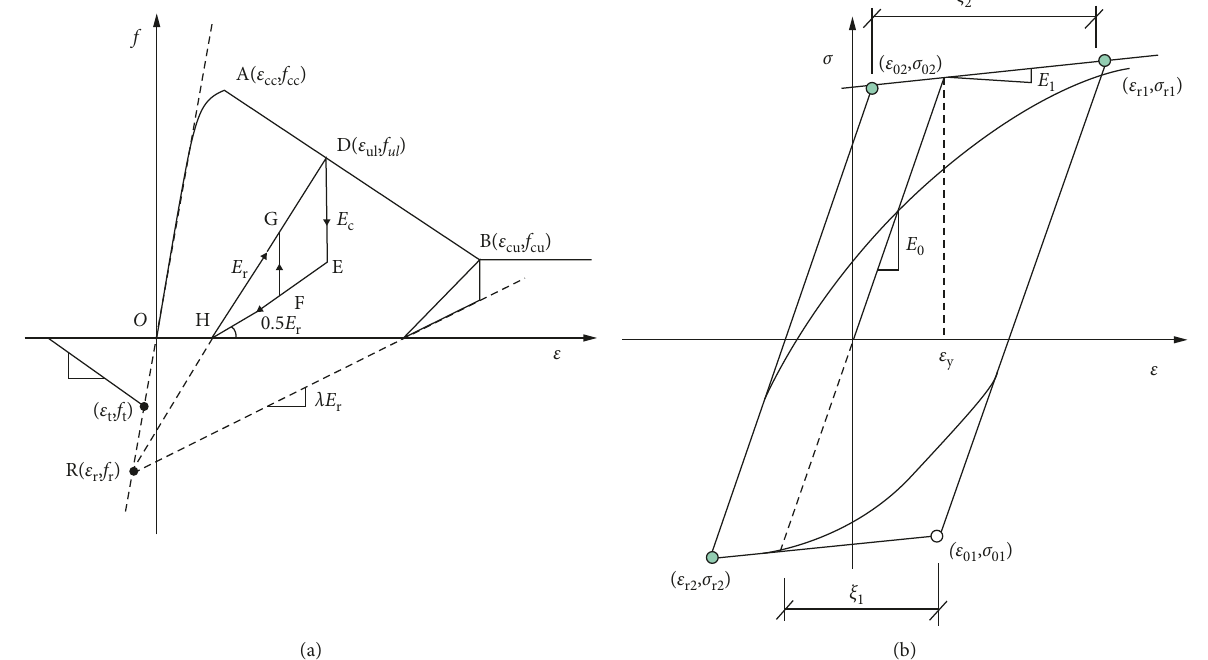
Figure 6: Constitutive model of reinforced concrete: (a) stress-strain curve of concrete; (b) stress-strain curve of the steel bar.